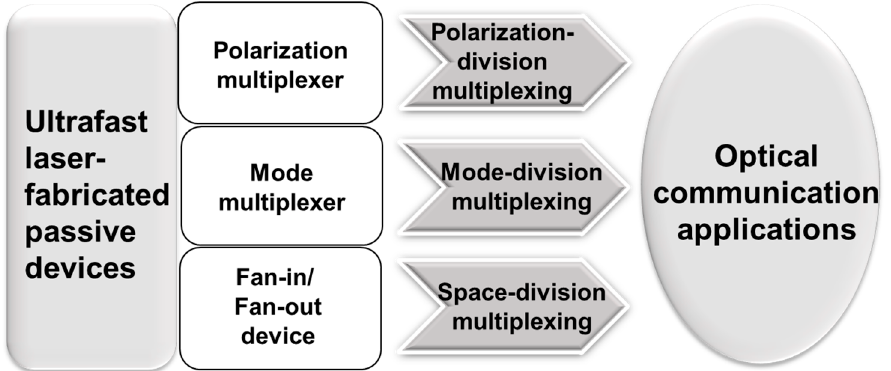
Figure 8. Femtosecond laser-fabricated passive devices for optical communication